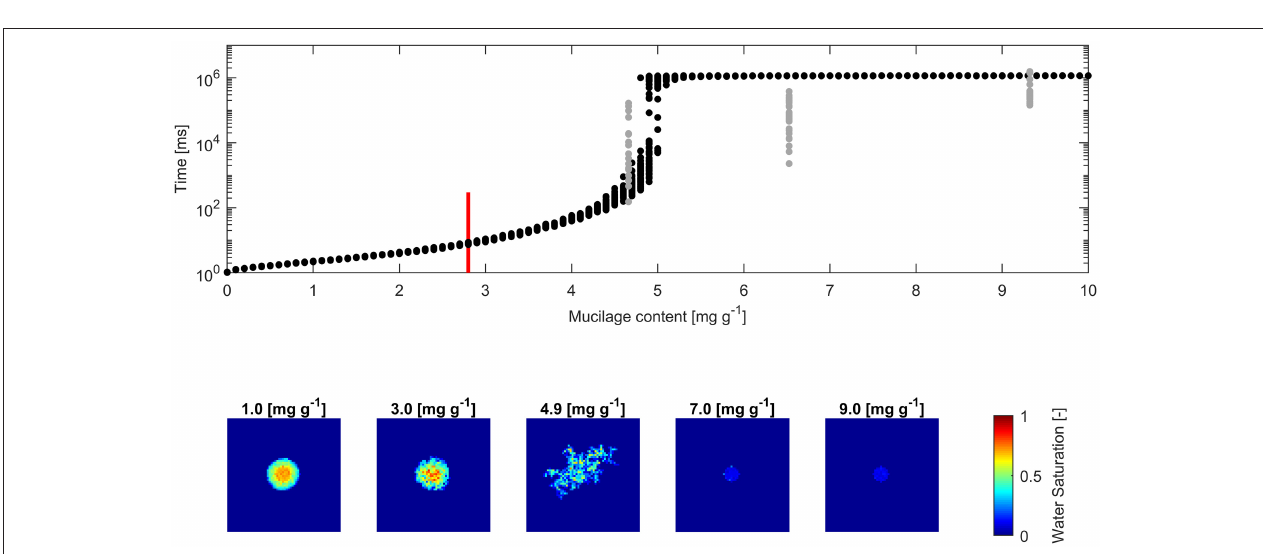
FIGURE 5 | (Top) Water drop penetration time (WDPT) fitted from optically detected drop volume decrease (gray dots) and simulated WDPT (black dots) in sand (0.125–0.2mm in diameter); Detection limit of 300ms is indicated for the lowest measured mucilage content of 2.8mg g − 1 by a red bar; (Bottom) left to right: